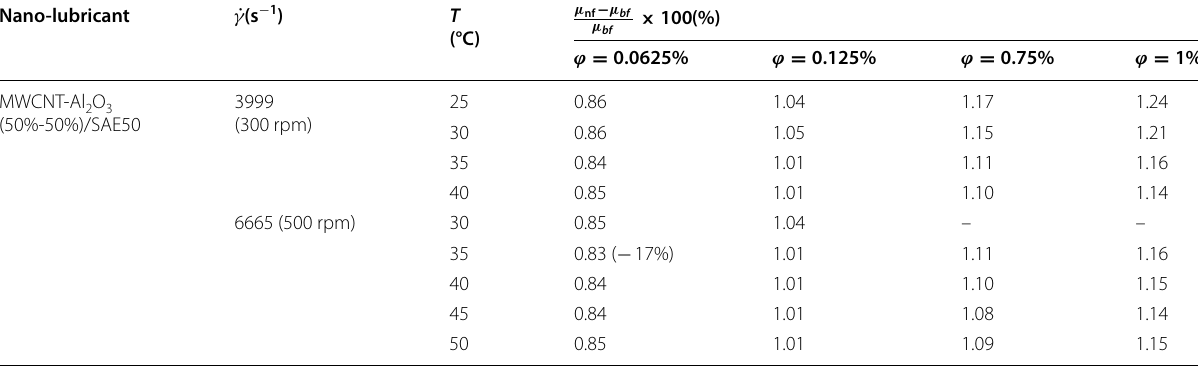
Table 5 Statistical data on the relative viscosity of nano-lubricants